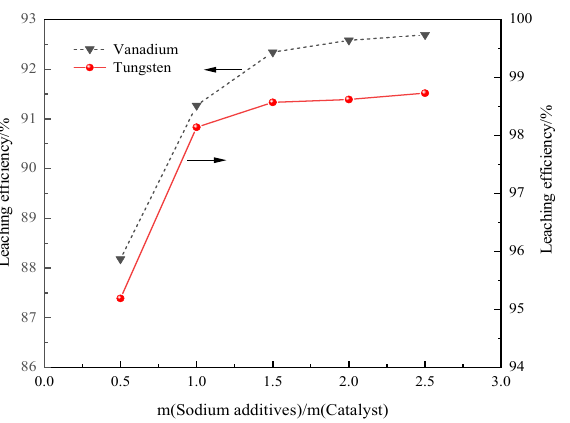
Figure 6. The effect of the mass ratio of sodium additive and catalyst on the leaching efficiencies of V and W.